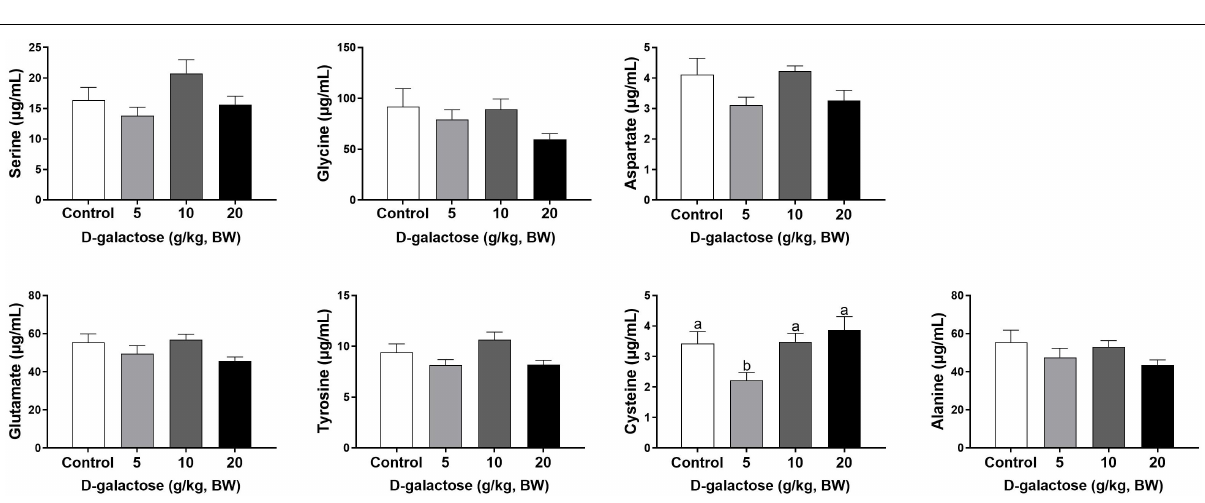
FIGURE 7 | Effects of D -galactose on non-essential amino acids in the serum at the second week. Data were expressed as the mean ± SEM. Different lower-case letters indicate a significant difference among different dosage of D -galactose ( P <